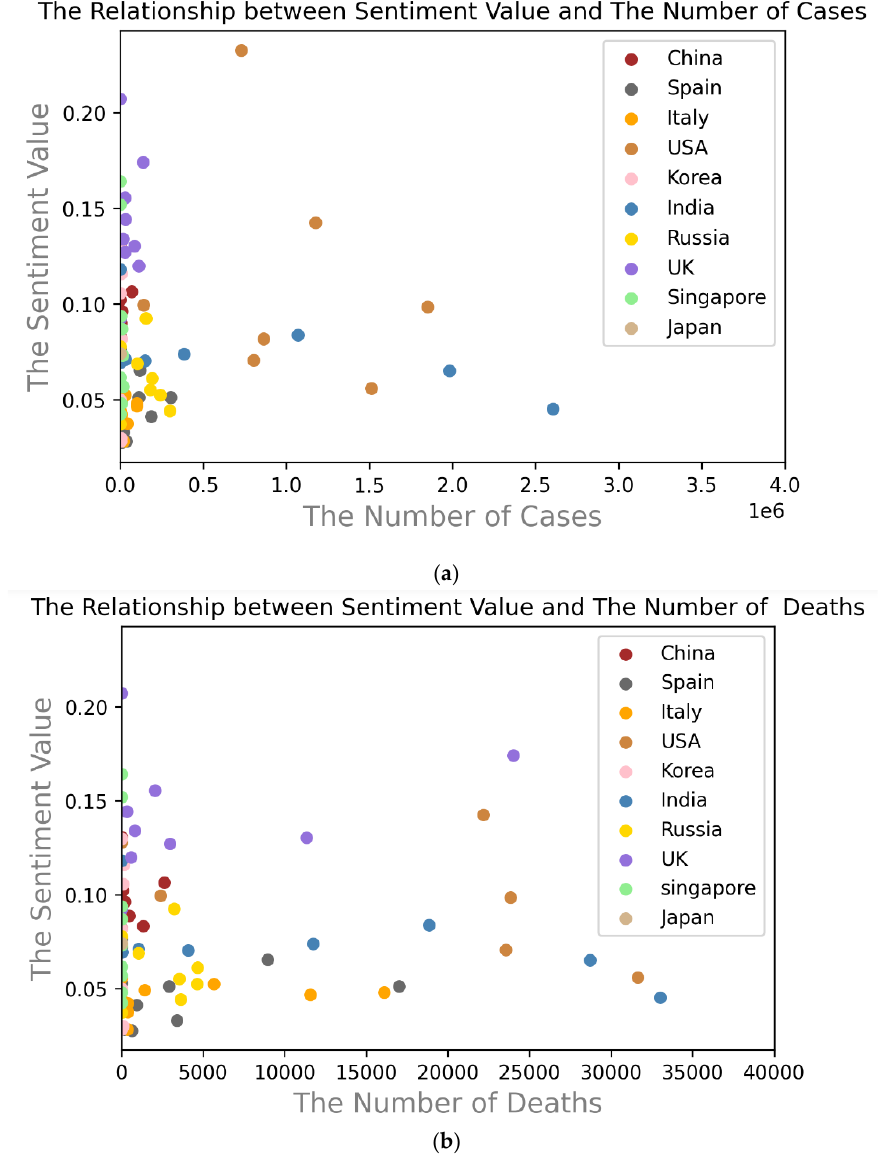
Figure 2. ( a ) The relationship between sentiment and the number of cases in different countries; ( b ) The relationship between sentiment and the number of deaths in different countries. Table 2. The Pearson correlation between the sentiment values and the number of cases/deaths. The Number of The Number of The Sentiment Cases Deaths